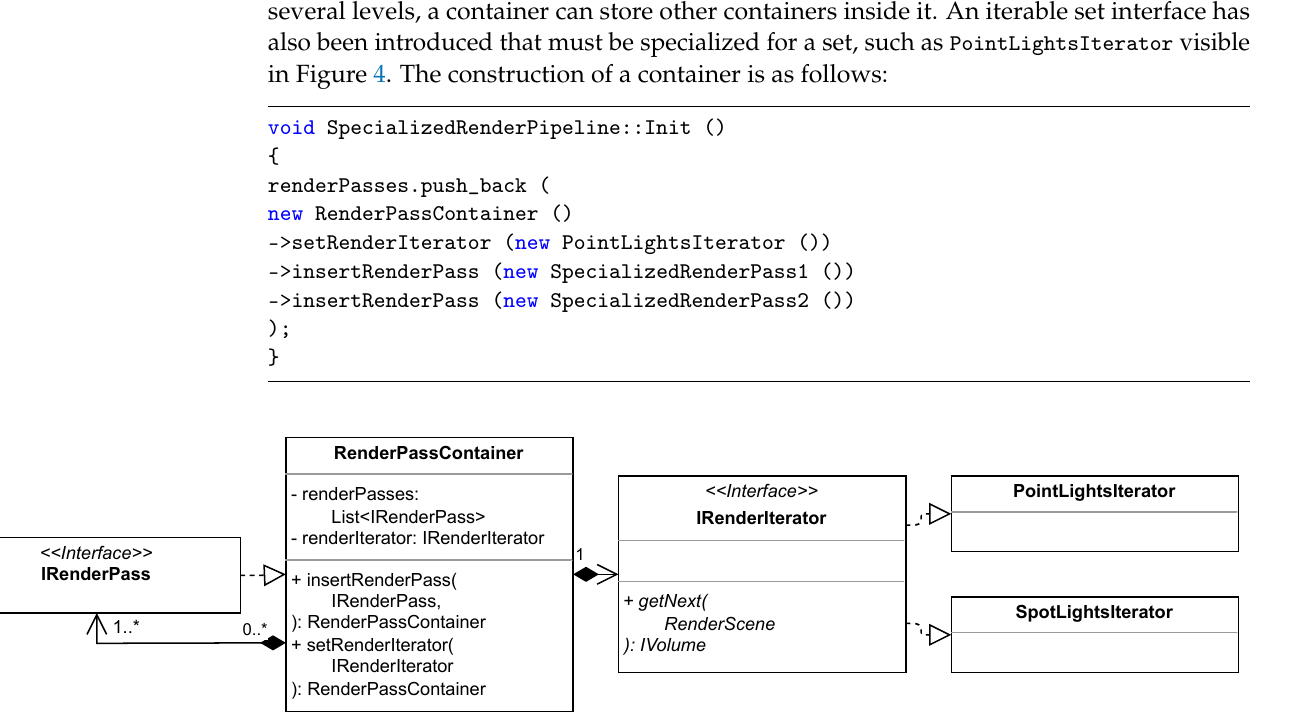
Figure 4. The class hierarchy used for sets iteration in the rendering